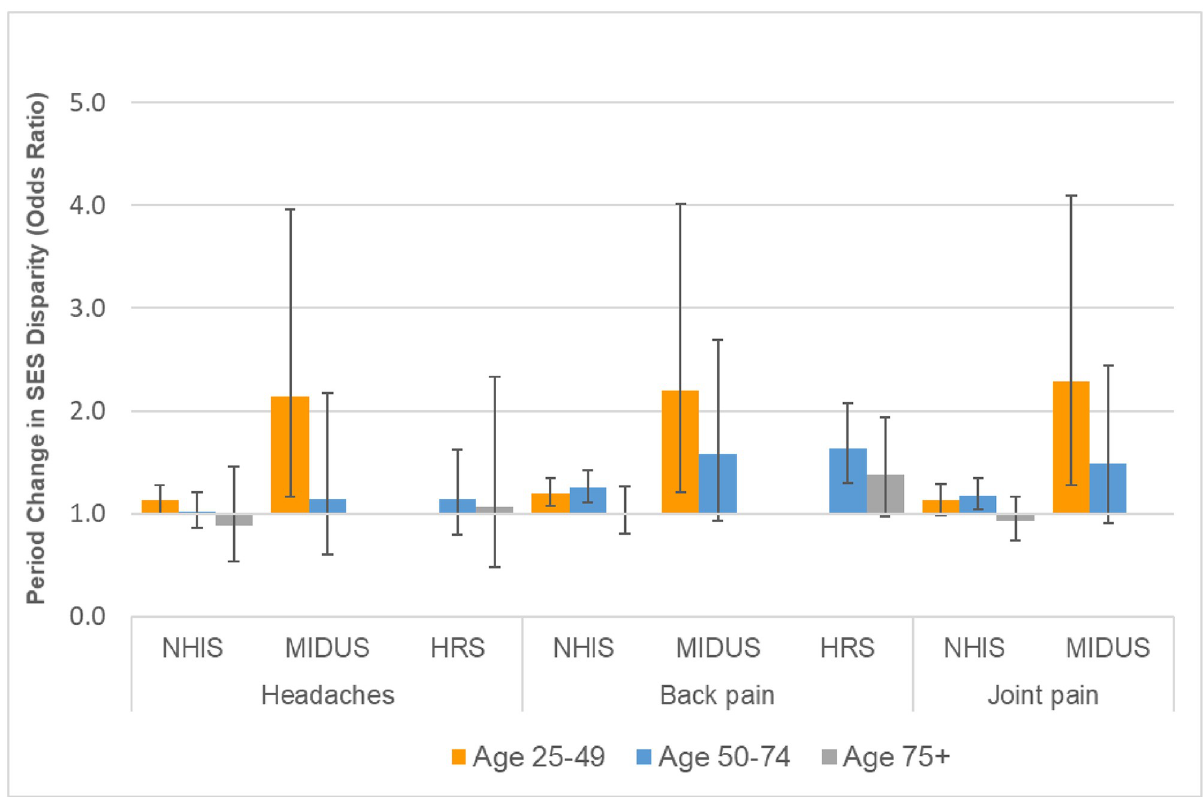
Fig 8. Changes over time in socioeconomic disparities in specific types of pain by age group. The SES disparity was computed as the odds ratio for the 90 th versus the 10 th percentile of SES. For HRS, there were very few respondents aged 75 and older with valid data for headaches or backpain in the 1996 or 1998 waves, when those questions were asked only of new respondents. Thus, the estimates for those outcomes from HRS were based on the odds ratio for 2016–18 relative to 1996–2003. The estimates were based on models fit separately for the three age groups. All models adjusted for sex, age (linear specification), race/ethnicity, period (categorical specification), and SES. The models also included the following 2-way interactions: age x period; age x SES; and period x SES.